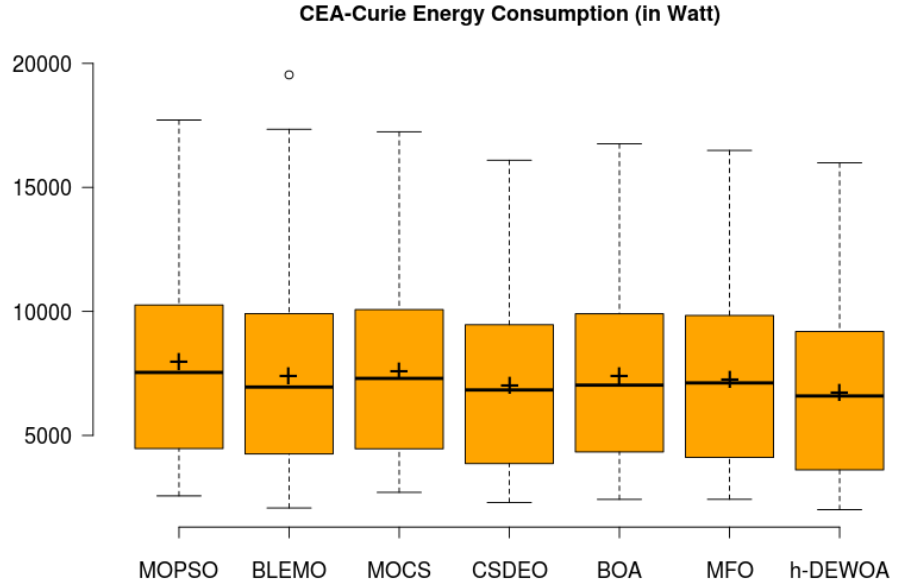
Figure 17. Comparative boxplot analysis of the overall energy consumption of h-DEWOA and recent state-of-the-art algorithms for CEA-Curie workloads.